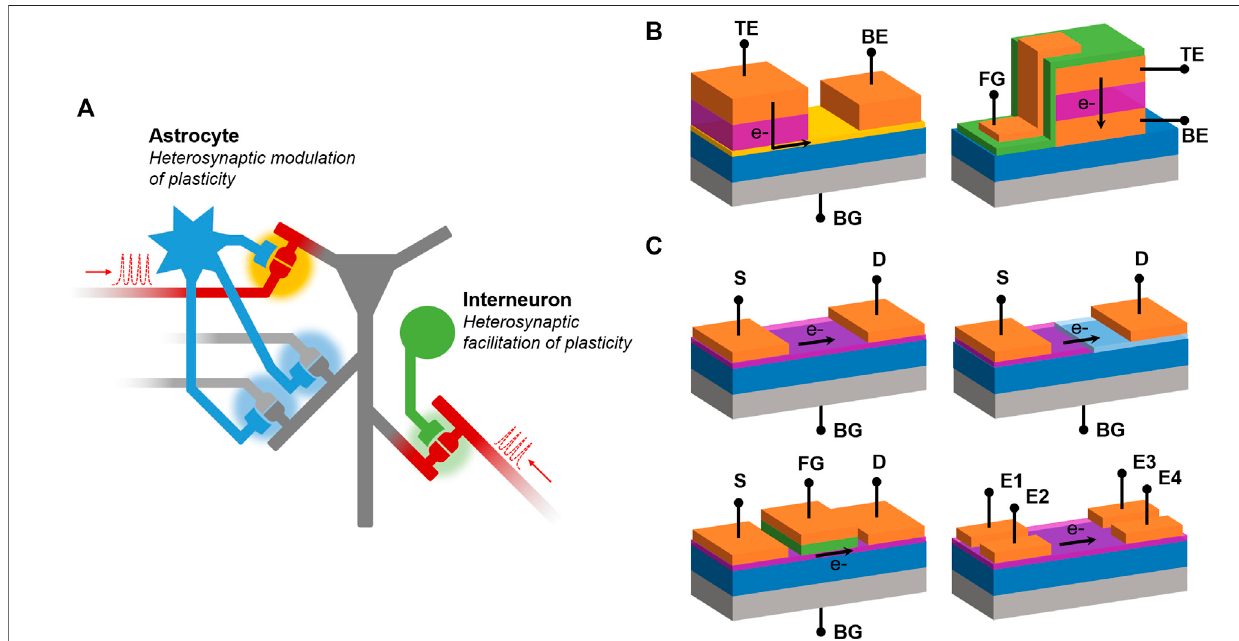
FIGURE1|(A) Schematicrepresentationsofspikingactivitiesbetweenneurons,modulatedbyanastrocyteandaninterneuron.Homosynapticplasticityoccursat synapses directly involved in a pre-synaptic activation (red connections). An astrocyte can induce heterosynaptic plasticity modulation in distant inactive synapses (blue areas) based on local synaptic activities (yellow area). An interneuron can act as an intermediate cell responsible for heterosynaptic facilitation (green area). (B, C) Schematic representations of recently reported arti fi cial synapses based on emerging multi-terminal vertical and planar memristive devices, featuring resistive switchingmaterials (transparentpurple) and electrodes (orange). (B) Typicalverticalmulti-terminaldevices, where the modulation electrodeis implemented eitherby the substrateasabackgate(BG)oratopgate(TG)separatedfromtheswitchingmaterialsbyadielectriclayer(green).Thetopelectrode(TE)andthebottomelectrode(BE) are placed at different altitudes, and both the switching mechanisms and the electronic current (e-) are vertical. (C) Various architectures ofplanar multi-terminal devices wheretheswitchingmechanismsandtheelectroniccurrentareparalleltothesubstrate.Inamemtransistorarchitecture,twoelectrodesareusedassource(S)anddrain (D), and the switching modulation is done using a back gate and/or a front gate. In this case, the switching medium can be composed of either a single material or an heterostructure combining different types of materials placed on top of each other or side-by-side. Other works also involve devices with multiple electrodes fabricated on top of the switching material, allowing to implement synaptic